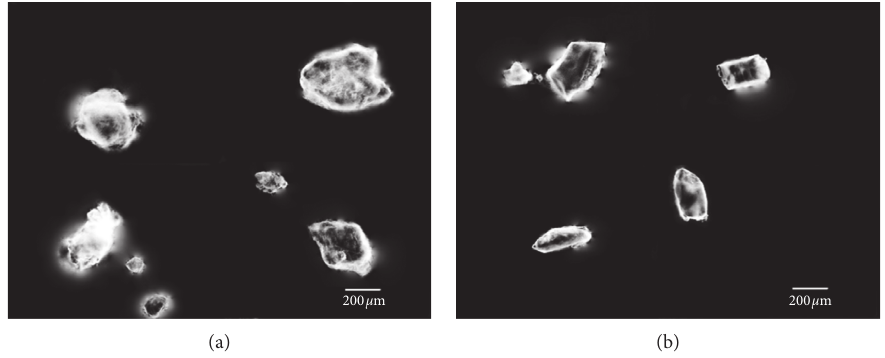
Figure 3: Images of the (a)MCPAM flocs and (b)CPAM